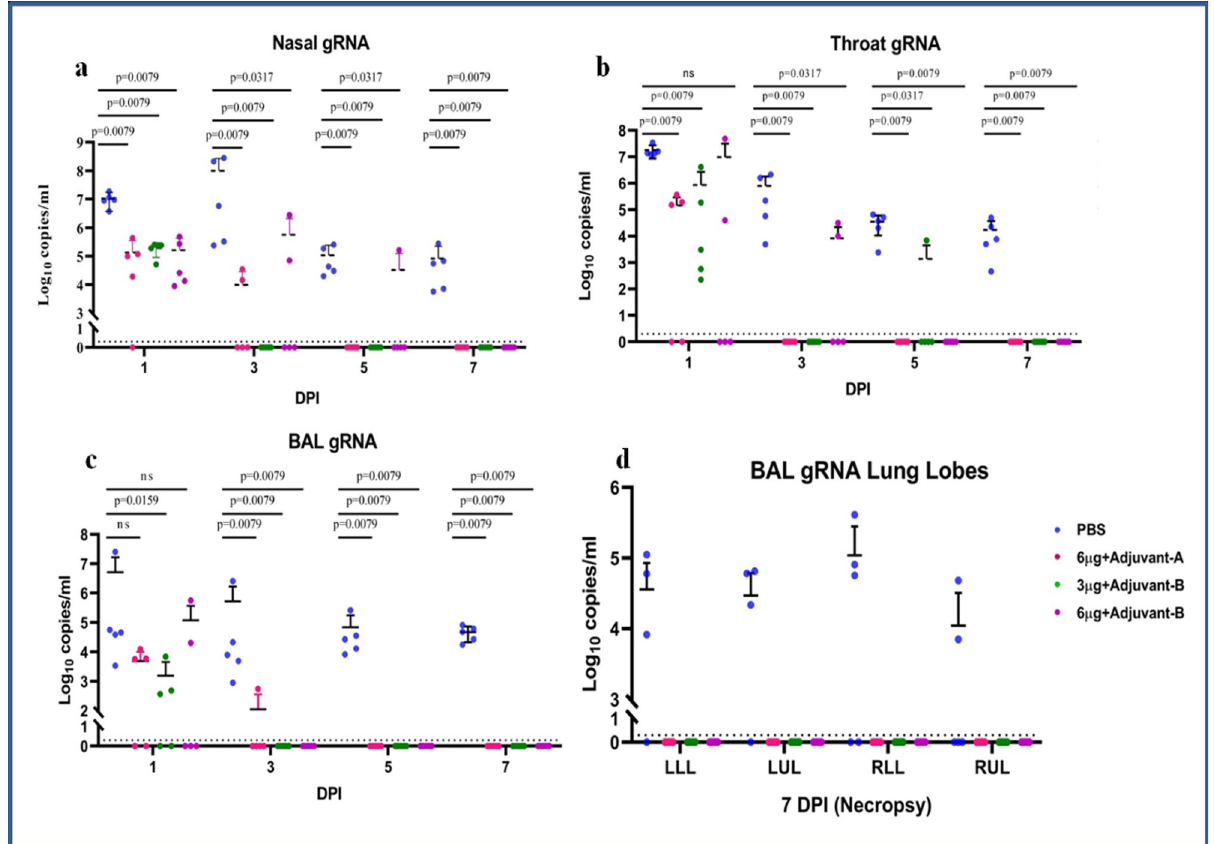
Fig. 3 Genomic viral RNA detection in respiratory tract specimens. Genomic viral RNA load in ( a ) nasal swab, ( b ) throat swab and ( c ) BAL at 1, 3, 5 and 7 DPI. d Genomic viral RNA load in different lobes of lungs at 7 DPI. The statistical signi fi cance was assessed using the Kruskal – Wallis test followed by the two-tailed Mann – Whitney test between the two groups; P values < 0.05 were considered to be statistically signi fi cant. The dotted lines indicate the limit of detection of the assay. Data are presented as mean values + / − standard deviation (SD). Statistical comparison was done by comparing the vaccinated group with the placebo group as a control. Group I = blue, group II = pink, group III = green and group IV = purple, number of animals = 5 animals in each group. Source data are provided as a Source Data fi